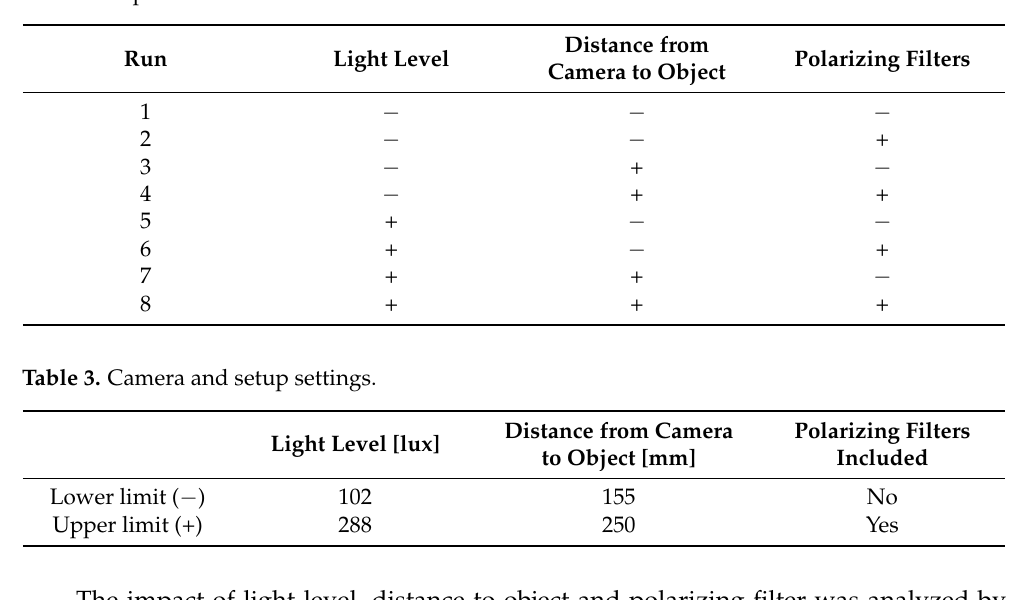
Table 2. Experimental scenarios.